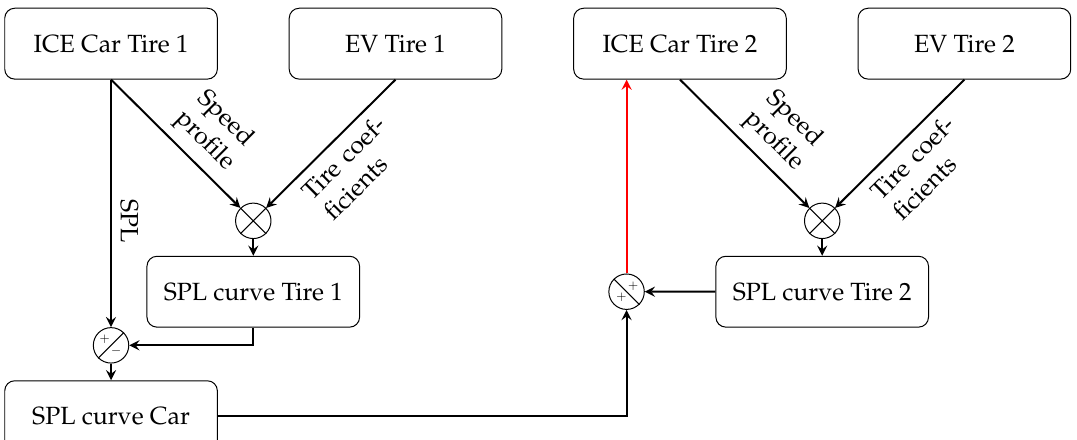
Figure 18. Principal sketch of validation of tire changing